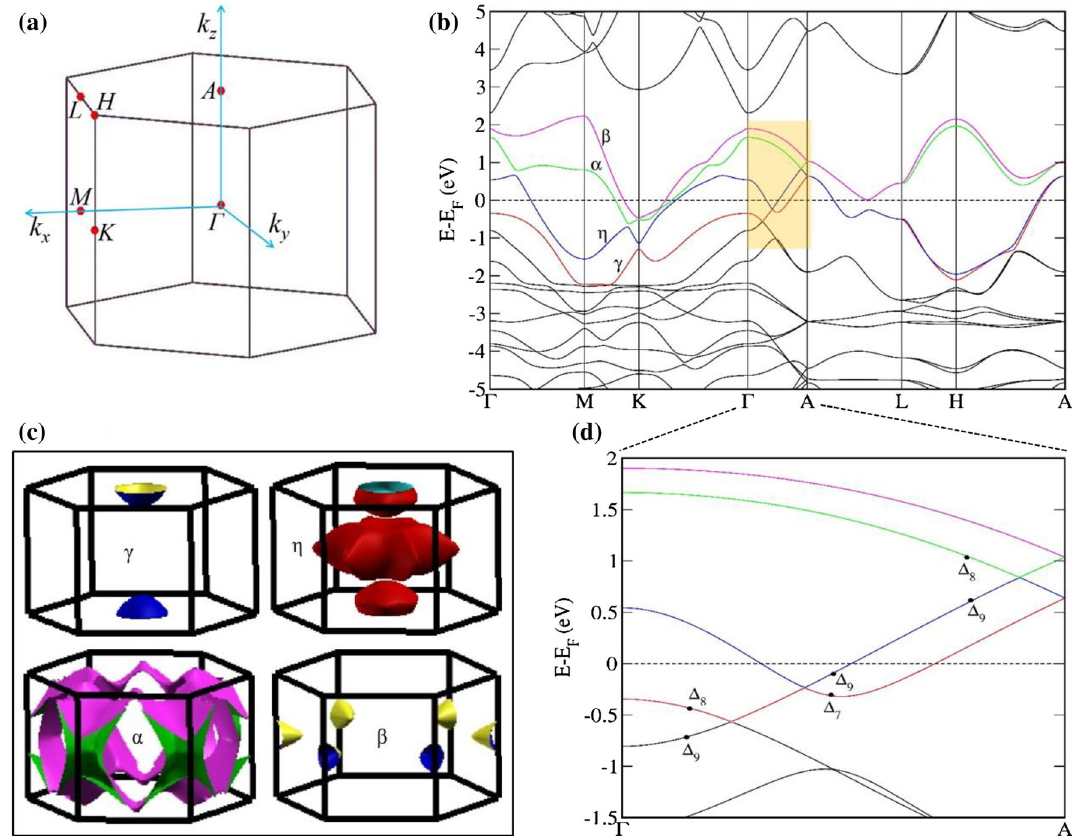
Figure 2. Electronic band structure and Fermi surface of PdTe. ( a ) Bulk Brillouin zone of PdTe. ( b ) Calculated bulk band structure of PdTe in the presence of spin–orbit coupling. The bands cross the Fermi level are represented in color. ( c ) Fermi surfaces of the corresponding band dispersions in ( b ). ( d ) An enlarged view of the shaded region in ( b ). The bands near nodal points are represented with irreducible representations (IRs). At Γ point, the IRs for γ, η, α and β bands are Γ 8 , Γ 7 , Γ 8 and Γ 9 respectively. Along Γ–A, these bands transformed to Δ 8 , Δ 7 , Δ 8 and Δ 9